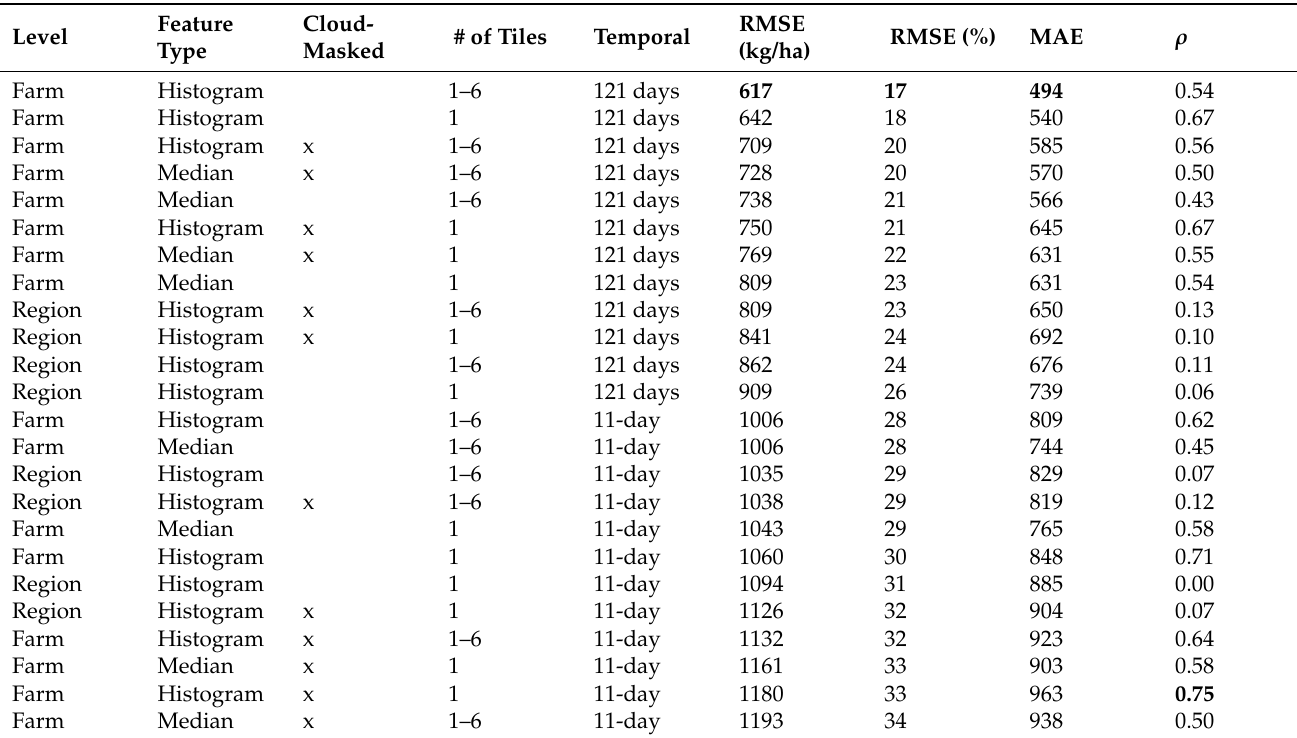
Table 2. The mean of root-mean-square errors (RMSE), the share of the error from the mean regional- level true yields (RMSE in %), mean absolute error (MAE), and the Pearson correlation coefficient ρ of regional-level predictions with temporal convolutional network for 2018–2020. The best value per error metric is printed in boldface. The number (#) of tiles means that the dataset are either from those municipalities that are overlaid on one or multiple (1-6) Sentinel-2 tiles.